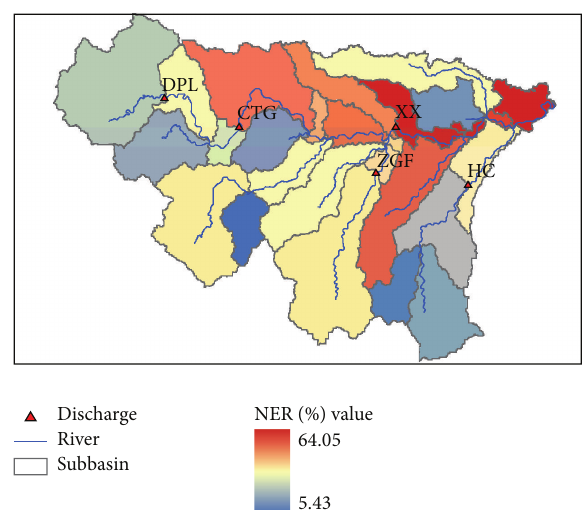
Figure 4: The NER (18) of the estimated streamflow for all subbasin outlets obtained by assimilating the streamflow observations at five interior gauges (DPL, CTG, ZGF, XX, and HC). The NER value at the subbasin outlet is displayed on the subbasin where it is